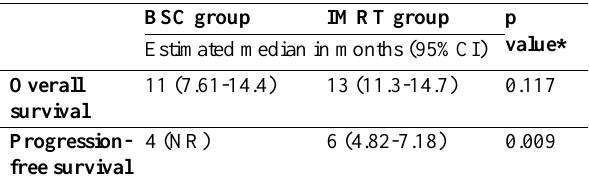
Table 2. Overall survival and